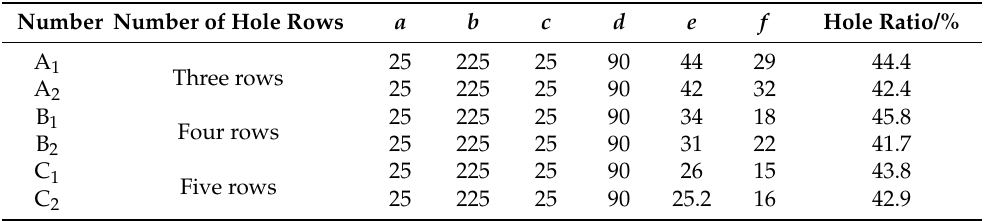
Table 1. Detailed dimensions of